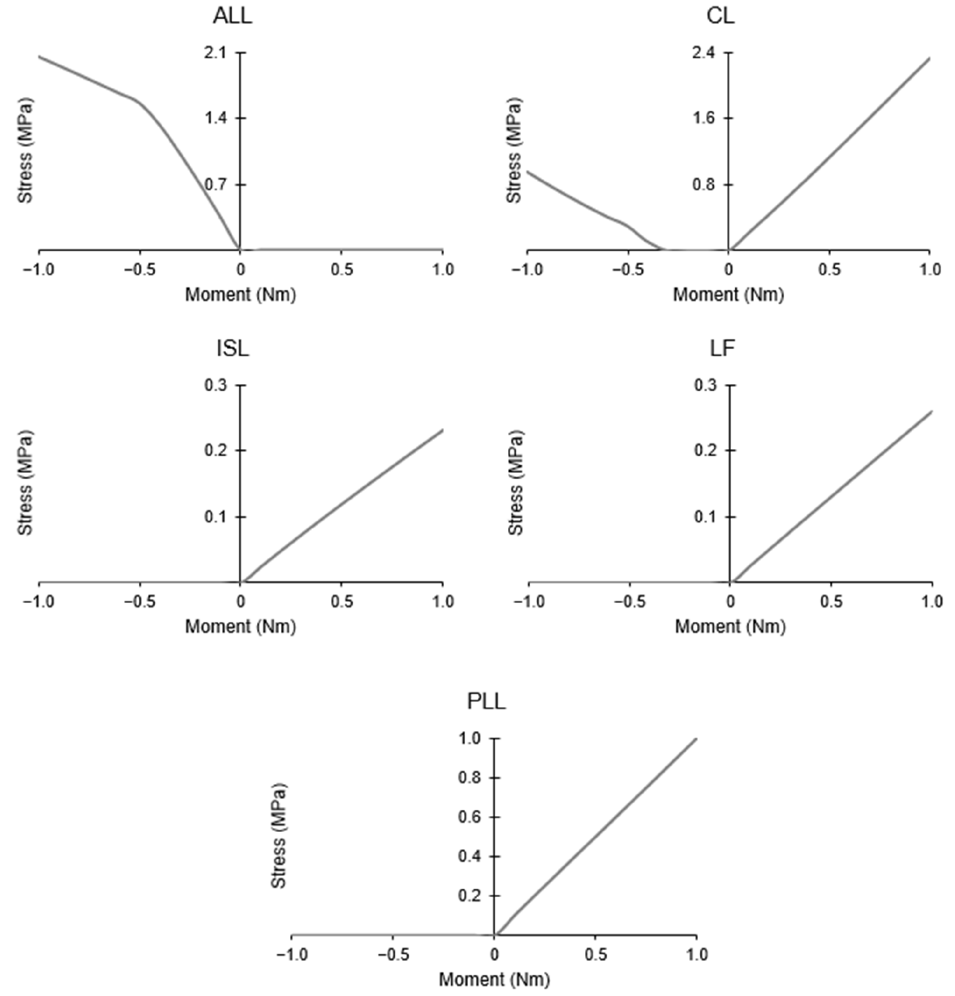
Figure 7. Maximum stress registered by each ligament during flexion–extension.